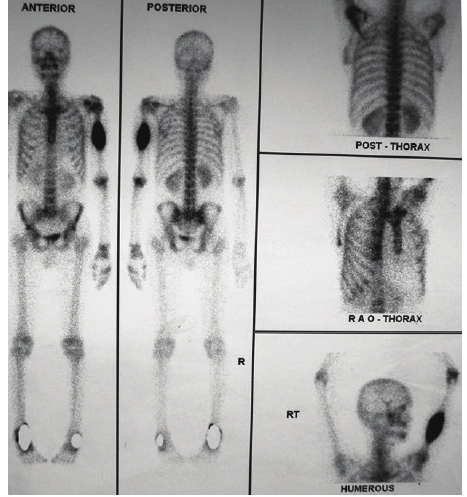
Figure 4: 99 m TcRadionuclide bone scan showing an increased uptake of radiotracer over the midhumerus of left side, suggestive of metastatic bony lesion.